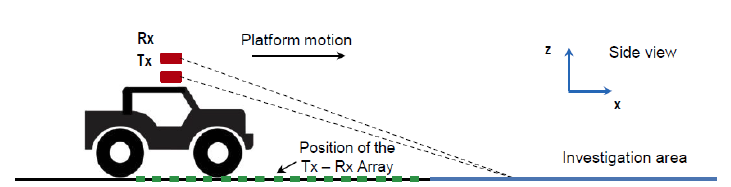
Figure 1. Side-view of the forward-looking ground-penetrating radar (FL-GPR) configuration and data collection